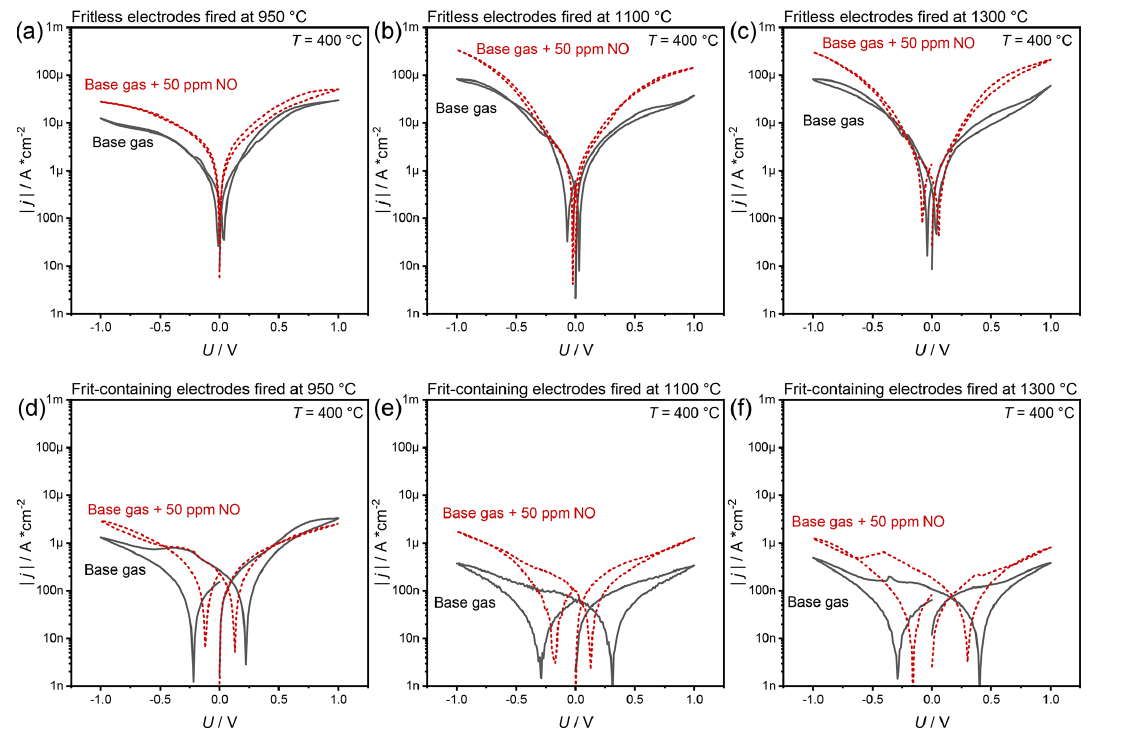
Figure 5. Polarization curves of sensors without (a–c) and with glass frit (d–f) , fired at 950 ◦ C (a, d) , 1100 ◦ C (b, e) , and 1300 ◦ C (c, f) .